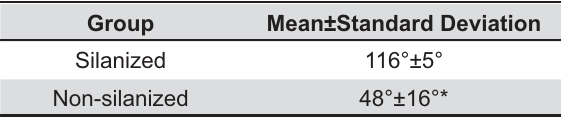
(cid:2)(cid:3)(cid:4)(cid:5)(cid:6)(cid:5)(cid:7)(cid:8)(cid:5)(cid:7)(cid:9)(cid:6)(cid:10)(cid:10)(cid:11)(cid:12)(cid:8)(cid:7)(cid:13)(cid:14)(cid:7)(cid:15)(cid:9)(cid:6)(cid:14)(cid:5)(cid:12)(cid:16)(cid:17)(cid:18)(cid:19)(cid:18)(cid:20)(cid:21)(cid:19)